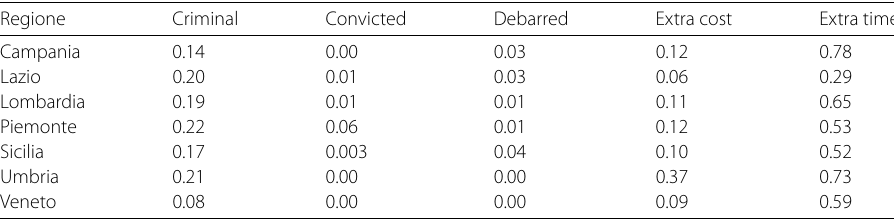
Table 5 Summary statistics: outcomes, by region Regione Criminal Convicted Debarred Extra cost Extra time Campania